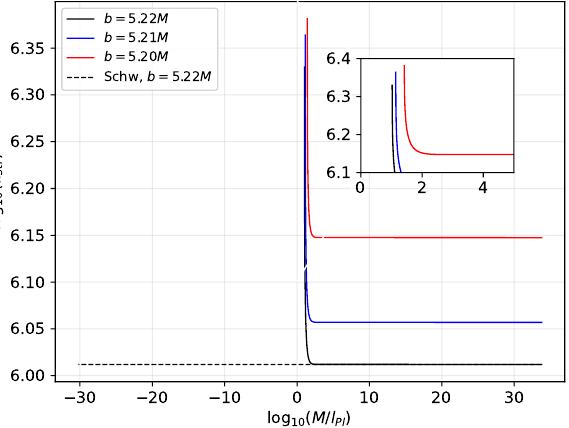
Figure 6. Behavior of strong deflection angle by Sgr. A* ( Left ) and M87* ( Right ). The black vertical dotted line is the corresponding mass of the supermassive black hole (SMBH). See text for details.